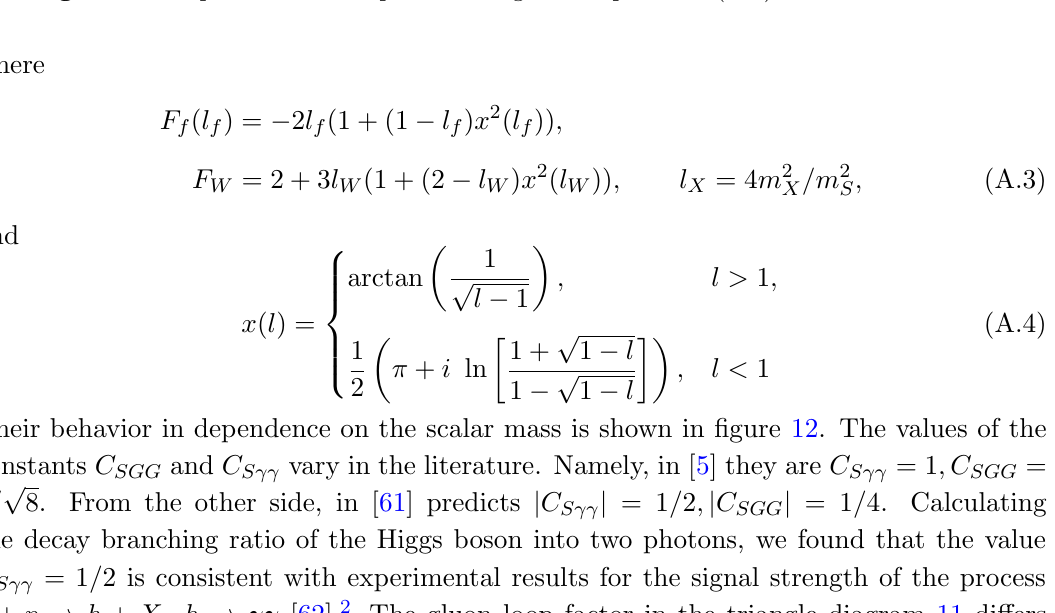
Figure 12 . Dependence of the photon and gluon loop factors (A.2) on the scalar